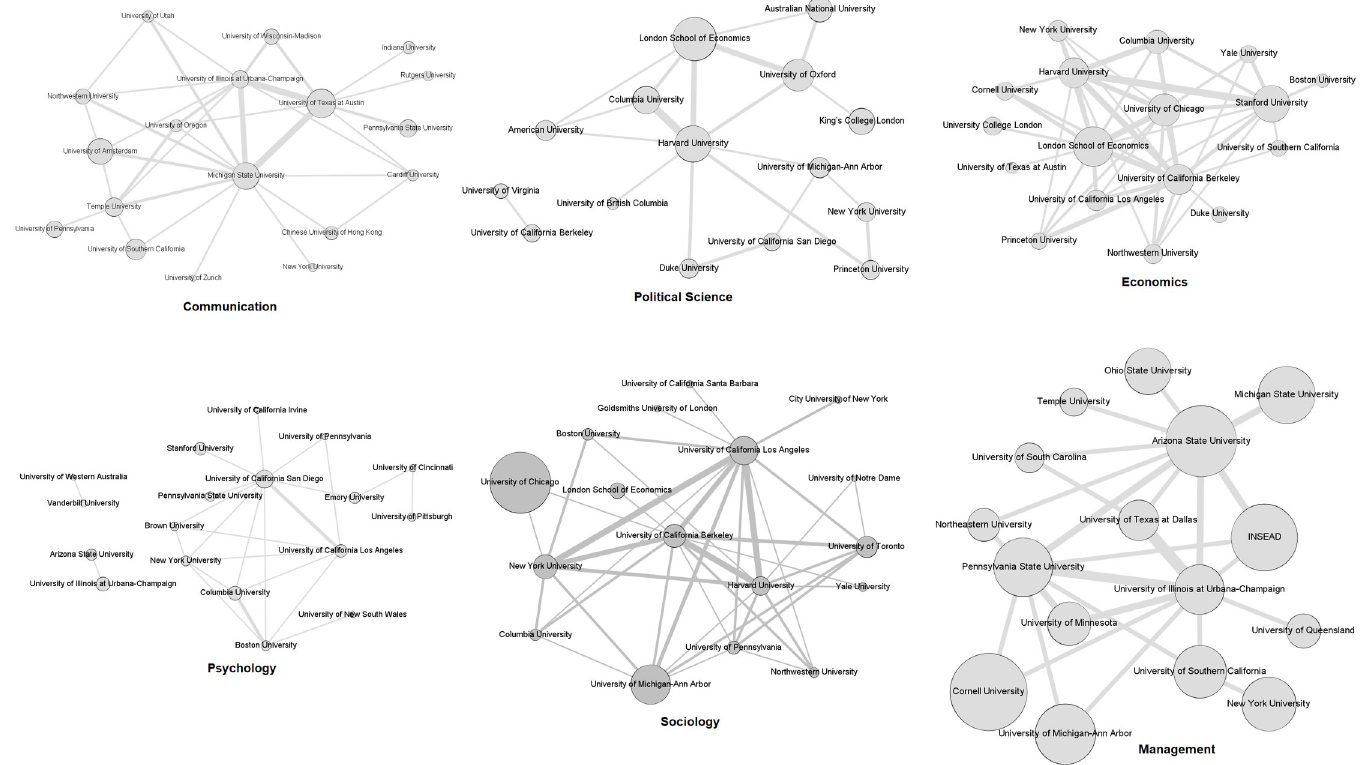
Fig 7. Projection of institutions for each field. Size of each node is proportional to the number of different scholars from the institution in EBs. Thickness of the lines is proportional to the number of common scholars in EBs between the institutions connected.